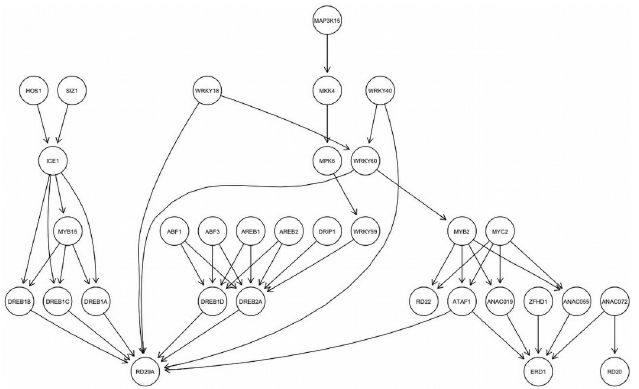
Fig 2. Bayesian network model of drought signaling pathway. Every circular node represents a biological element in the drought signaling pathway. Every edge or black arrow represents the causal biological relationship between the nodes. Associated with every node is a θ parameter that represents the local probability distribution of the